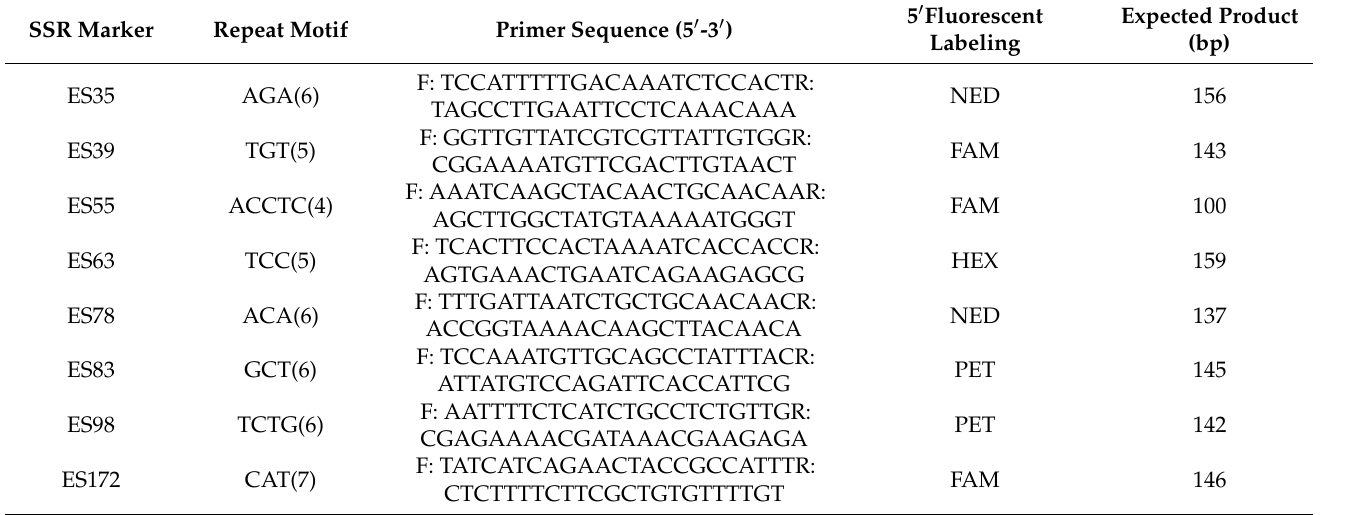
Table 1. Characteristics of eight EST-SSR markers in this